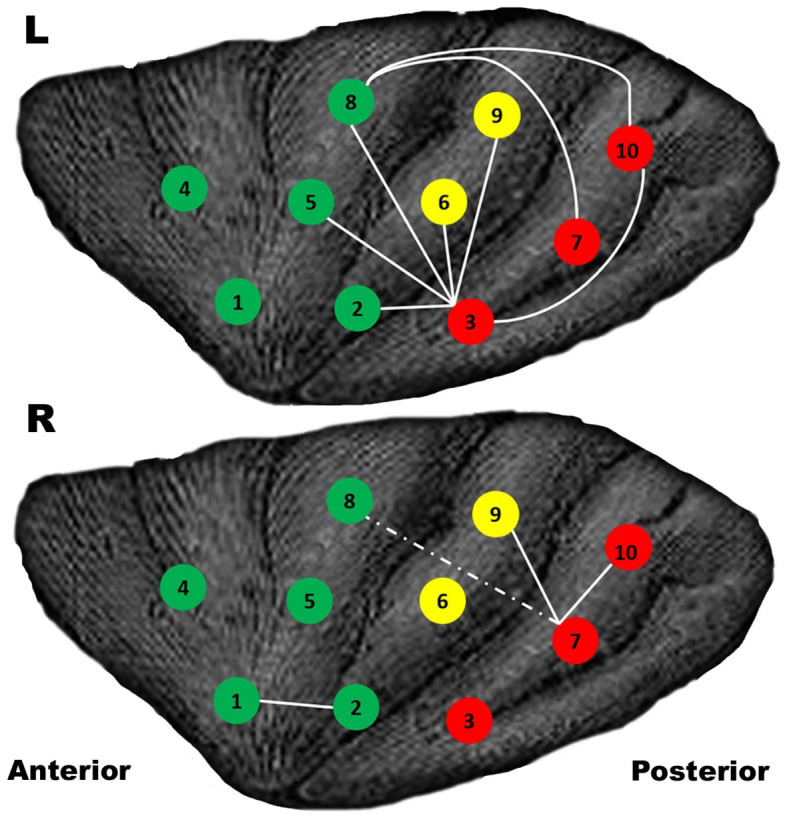
Enhanced FC of the insular subregions.The white lines denote the pathways where experts had significant enhancements compared with amateurs, p <0.05, FDR-corrected. The dashed line represents p <0.01, uncorrected. The higher FC reveals a pattern of anterior-posterior integration and left-lateralisation. ROIs 1, 2, 4, 5 and 8 (green) were located in the anterior subregions. ROIs 3, 7 and 10 (red) were located in the posterior subregions. ROIs 6 and 9 (yellow) were located in the transitional subregions.